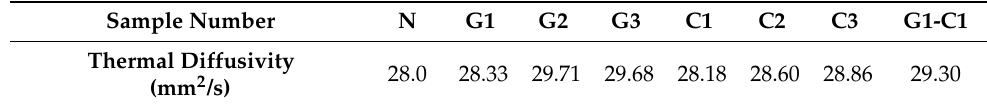
Table 5. Thermal diffusivity of WC–Co cemented carbide.